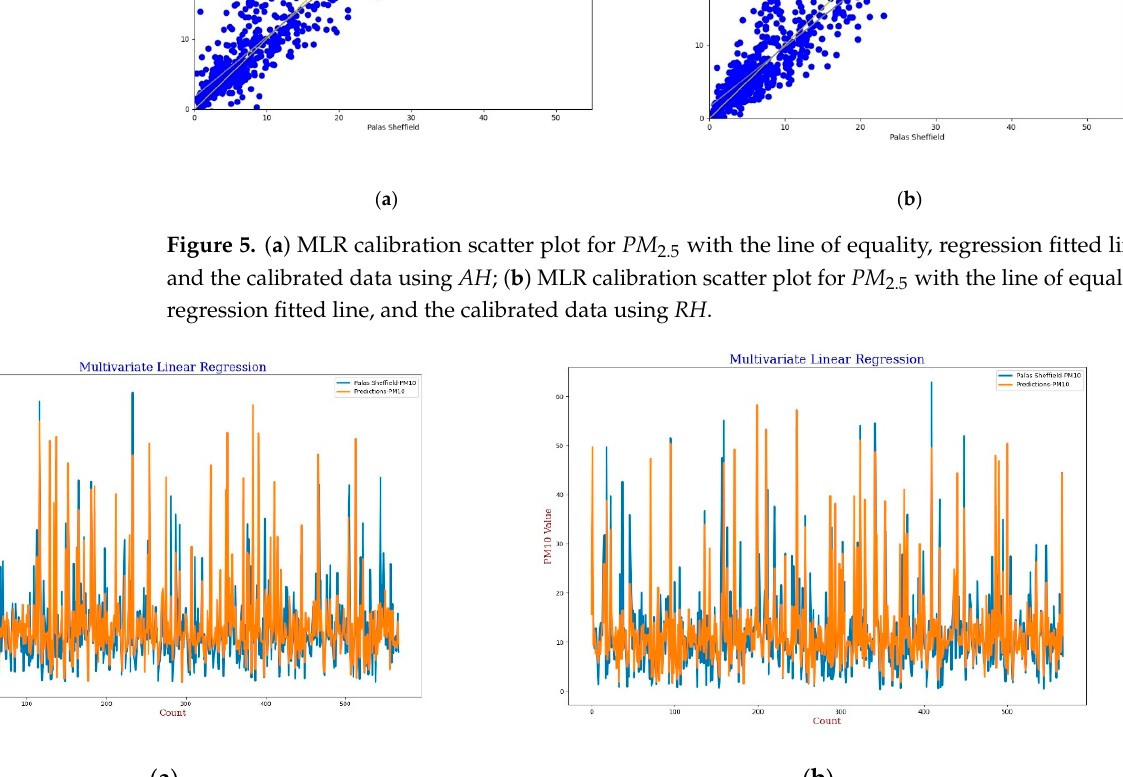
Figure 6. ( a ) MLR calibration plot for PM 10 using AH . Blue colour represents the reference data and orange colour represents the calibrated data; ( b ) MLR calibration plot for PM 10 using RH . Blue colour represents the reference data and orange colour represents the calibrated data.